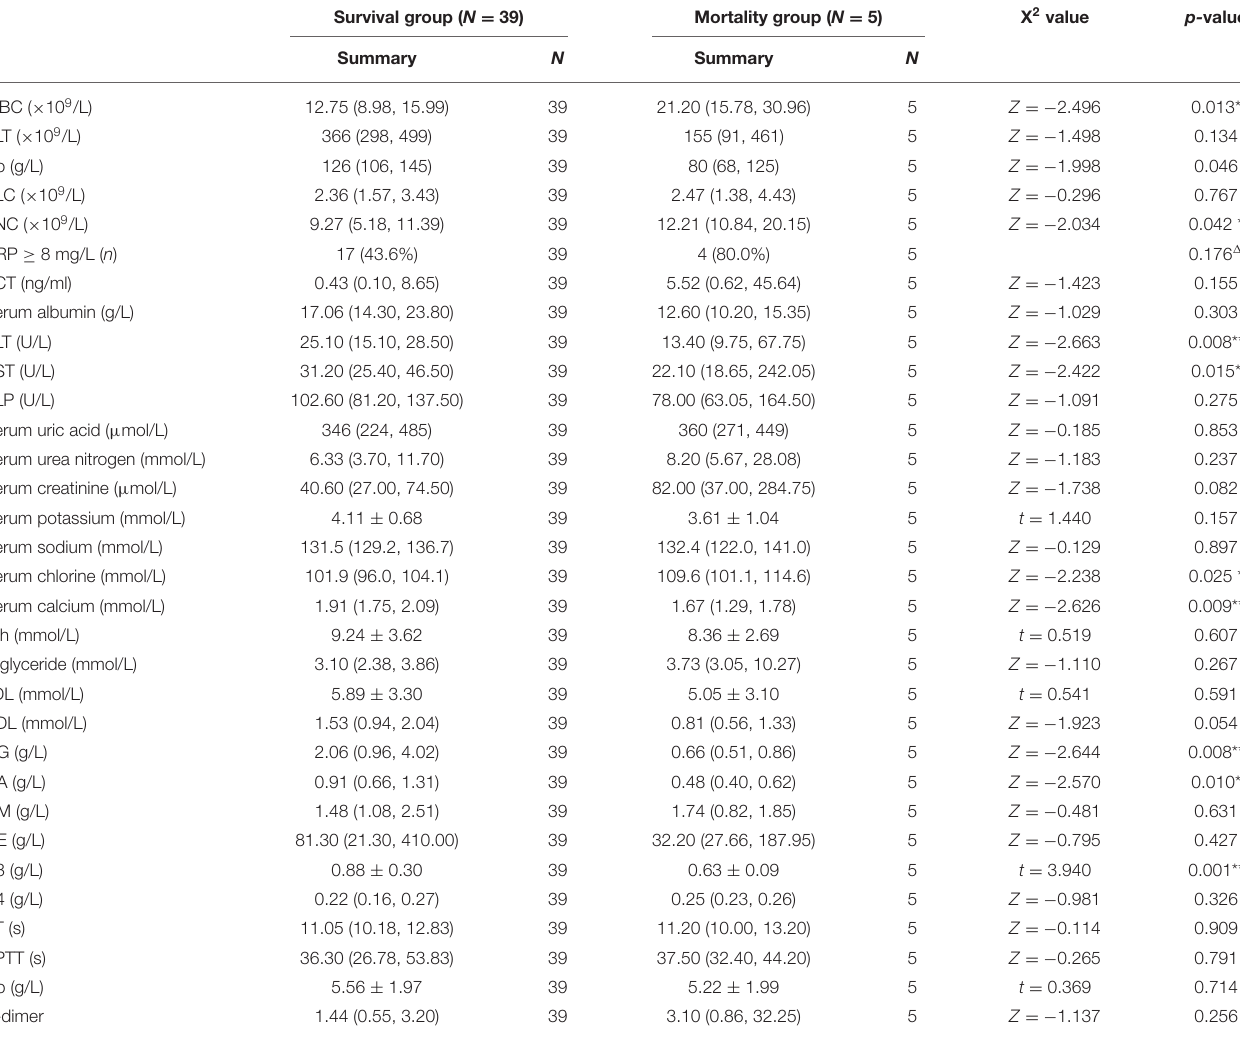
TABLE 6 | Univariate analysis of risk factors for poor prognosis of SIG in children with INS. Survival group ( N = 39) Mortality group ( N = 5) X 2 value p- value Summary N Summary